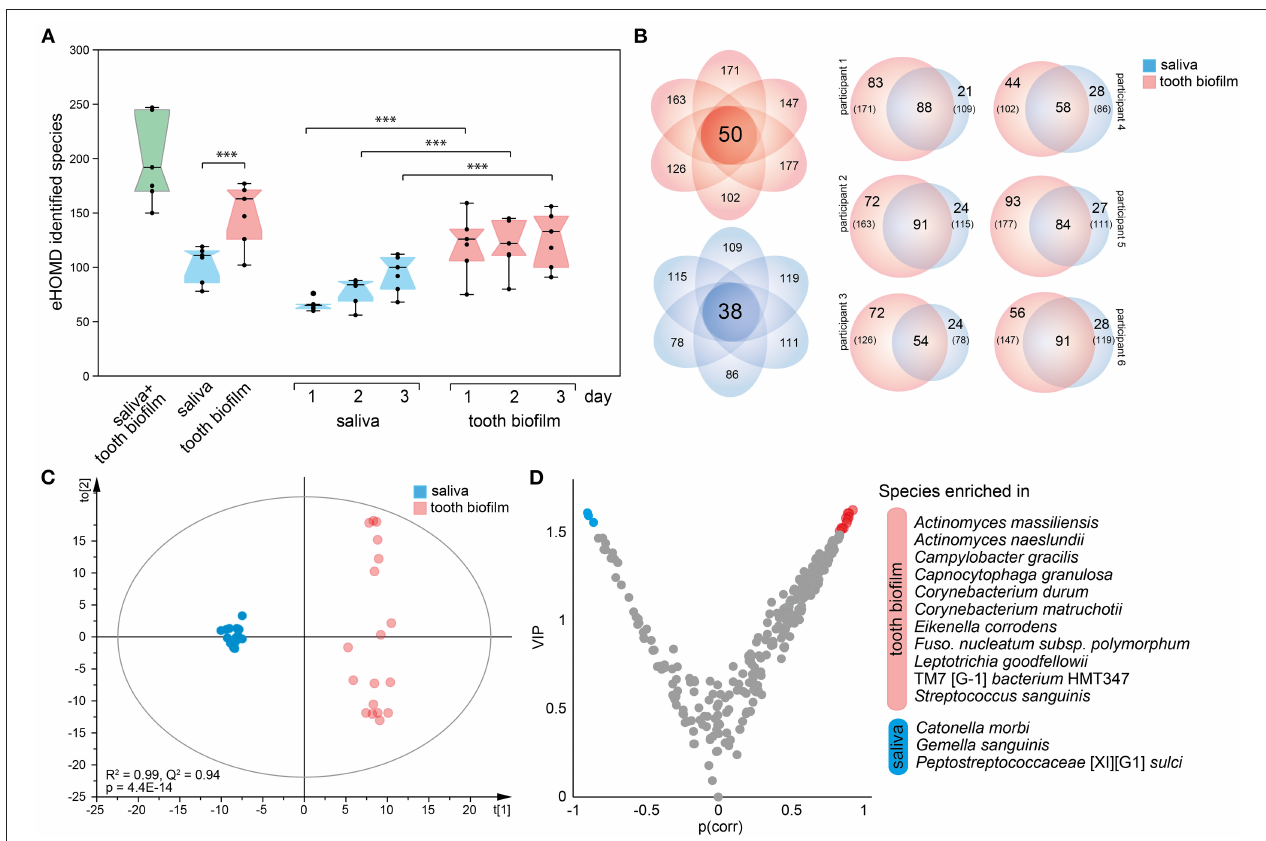
FIGURE 3 | Characteristics of tooth biofilm vs. the saliva microbiota. (A) Box plots showing the median with 25 and 75% percentile limits for the number of species in the pan-microbiota, and for the tooth biofilm pooled for all 16 tooth regions, and saliva, respectively. *** p < 0.001. (B) Venn diagrams showing saliva (blue) and tooth biofilm (red) overlapping species at any accumulation time in (left) all participants or (right) each of the six participants. (C) OPLS-DA derived score scatter plot illustrating the clustering of samples from saliva vs. tooth biofilm based on species abundance profiles in the two sample types. The plot of discrimination component t [1] vs. orthogonal component to [1] confirms the separation of saliva and tooth biofilm microbiotas in each of the participants and shows that tooth biofilm samples exhibit greater within-subgroup diversity that is not linked to the discrimination component. (D) Volcano plot of p (corr) (PLS correlation coefficient > 0.5) vs. variable influence in projection (VIP) values ( > 1.5) highlighting the most influential bacterial species in the separation of the two sample